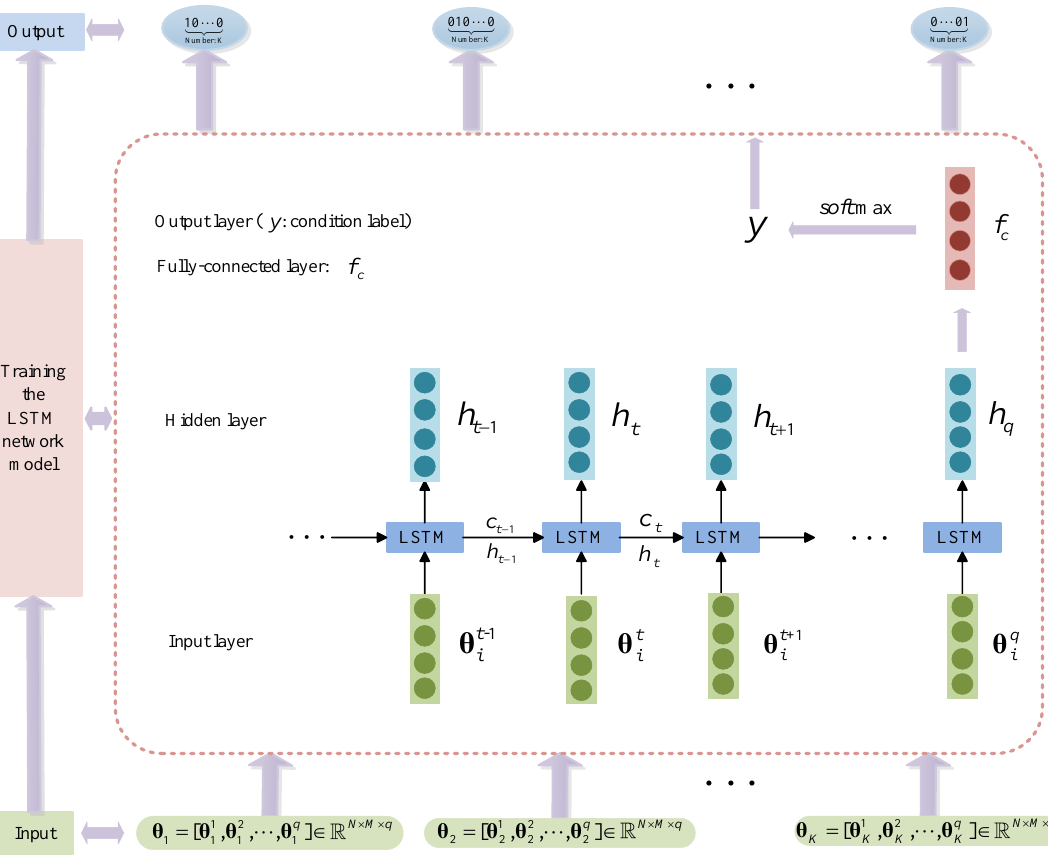
Figure 4. LSTM-based FDI model.